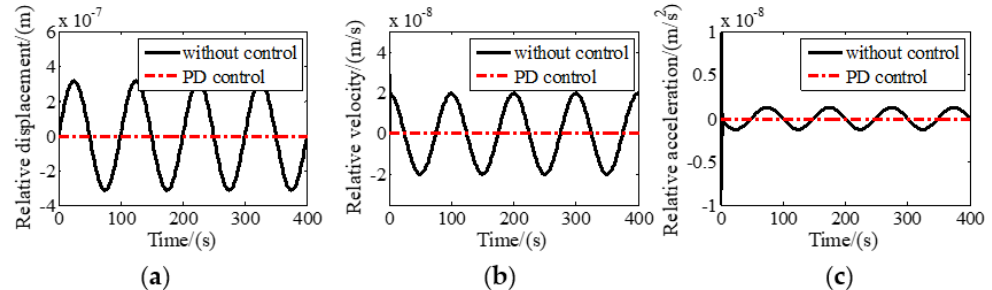
Figure 4. Relative motion with and without tracking control along Z direction: ( a ) Relative displacement; ( b ) relative linear velocity; ( c ) relative linear acceleration.